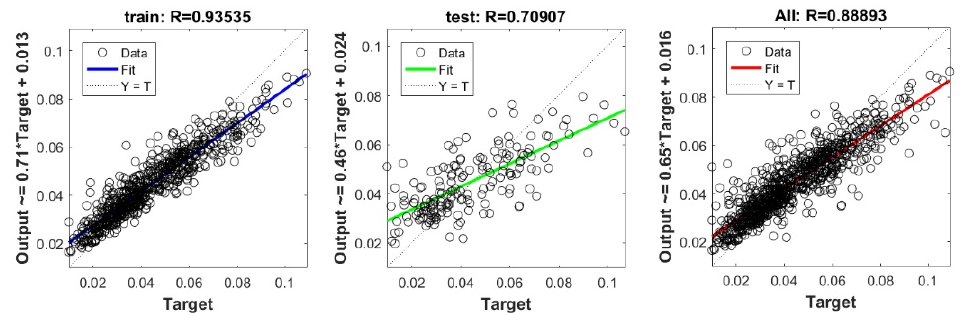
Figure A17. Scatter plots between target and output value by the GT-RF model.